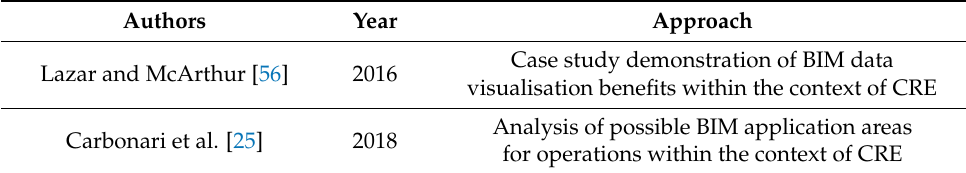
Table 2. Related studies investigating BIM uses for